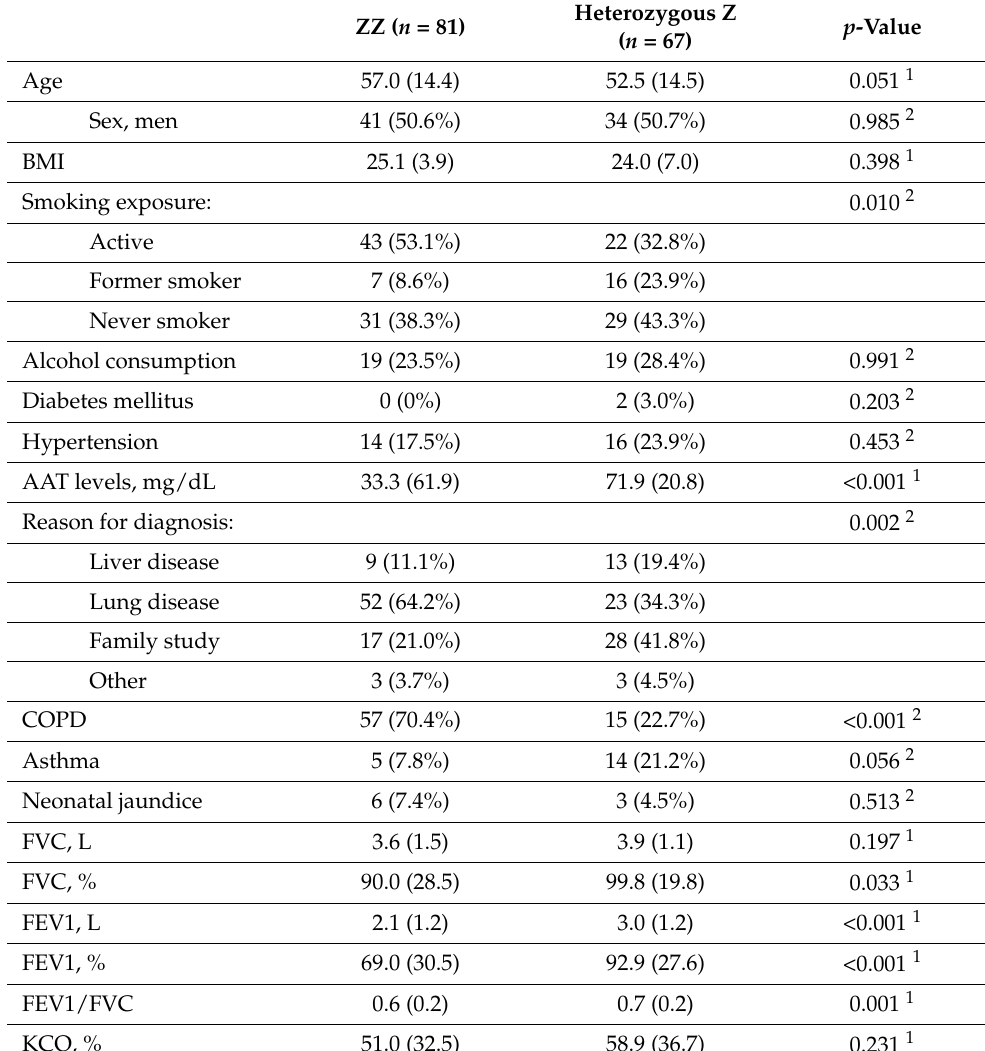
Table 1. Baseline characteristics of the patients included by AAT